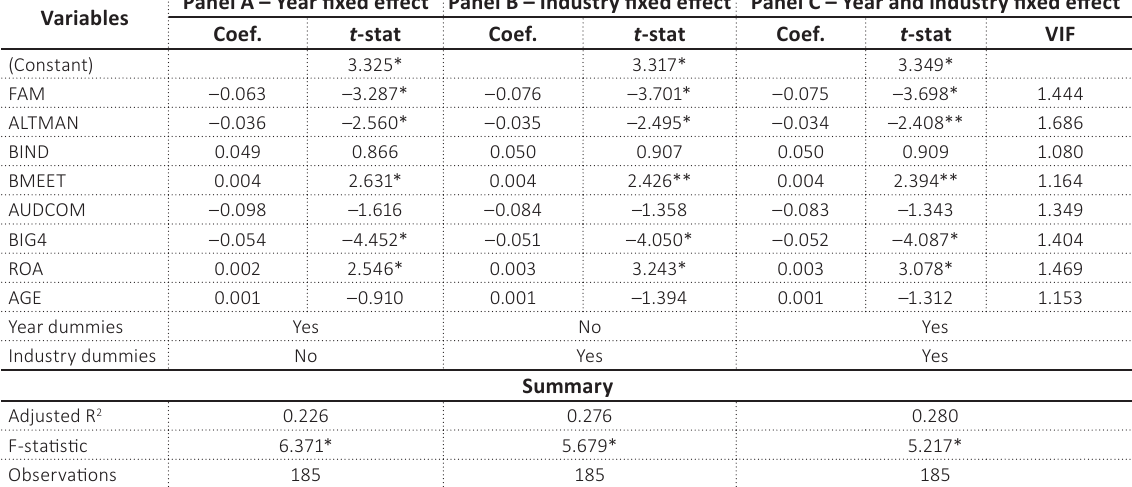
Table 5. Fixed effect regression results